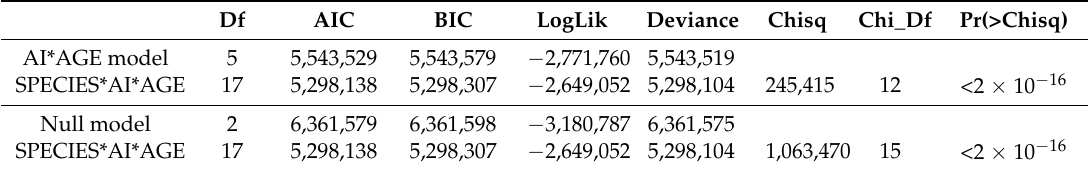
Table 1. Accuracy assessment of the models. Parameters: Df (number of parameters in the model), Pr(>Chisq) (significance level).